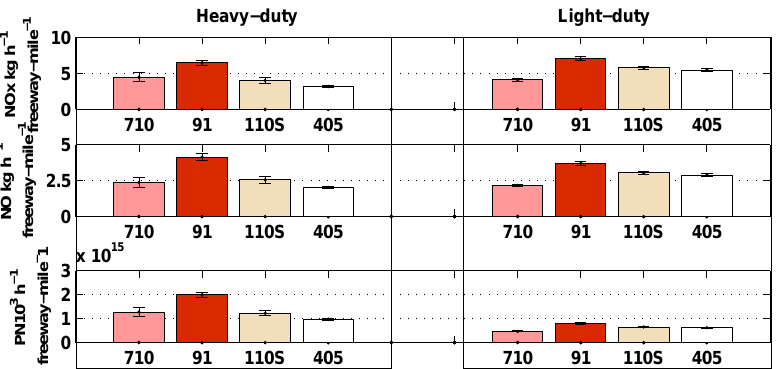
Fig. 5. Average hourly freeway emission rates for four freeways within LA County lines. 110S refers to I-110, the southern segment with mixed fuel fleet.